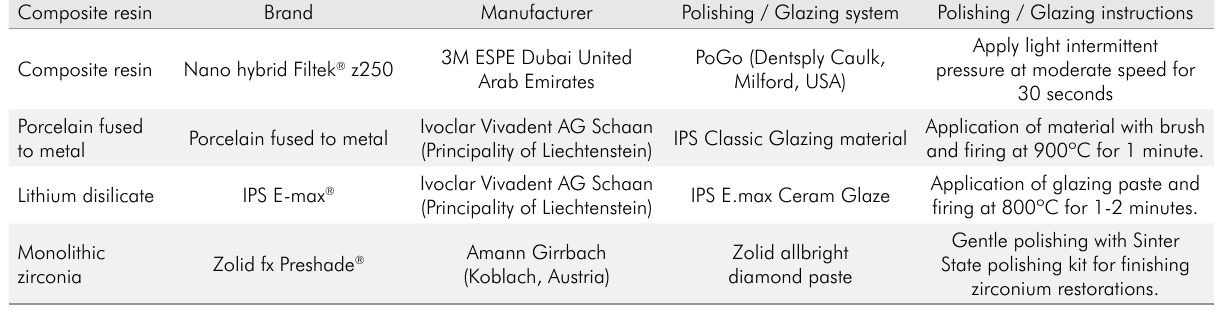
Table 1. Tested materials with their polishing / glazing protocols.